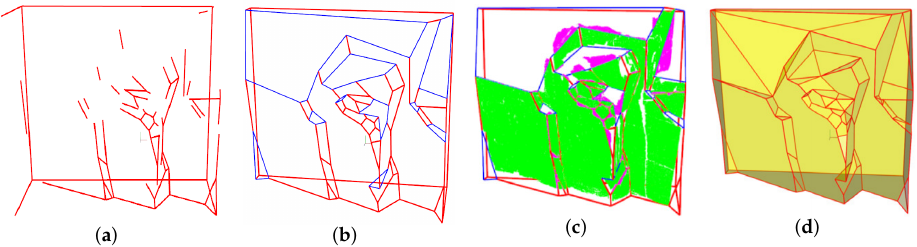
Figure 9. Results of boundary prediction. The blue line segment represents the boundary obtained by prediction.( a ) A basic model. ( b ) The best prediction result. ( c ) Effectiveness test. Covered points (green): 255,157. Remaining points (purple): 21,051. ( d ) The reconstruction result.